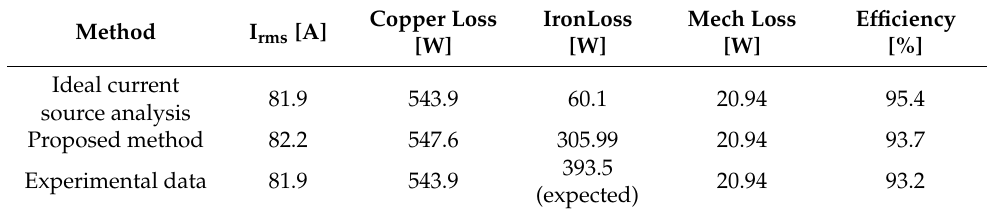
Table 4. Case 1: 125 Nm at 1000 rpm.